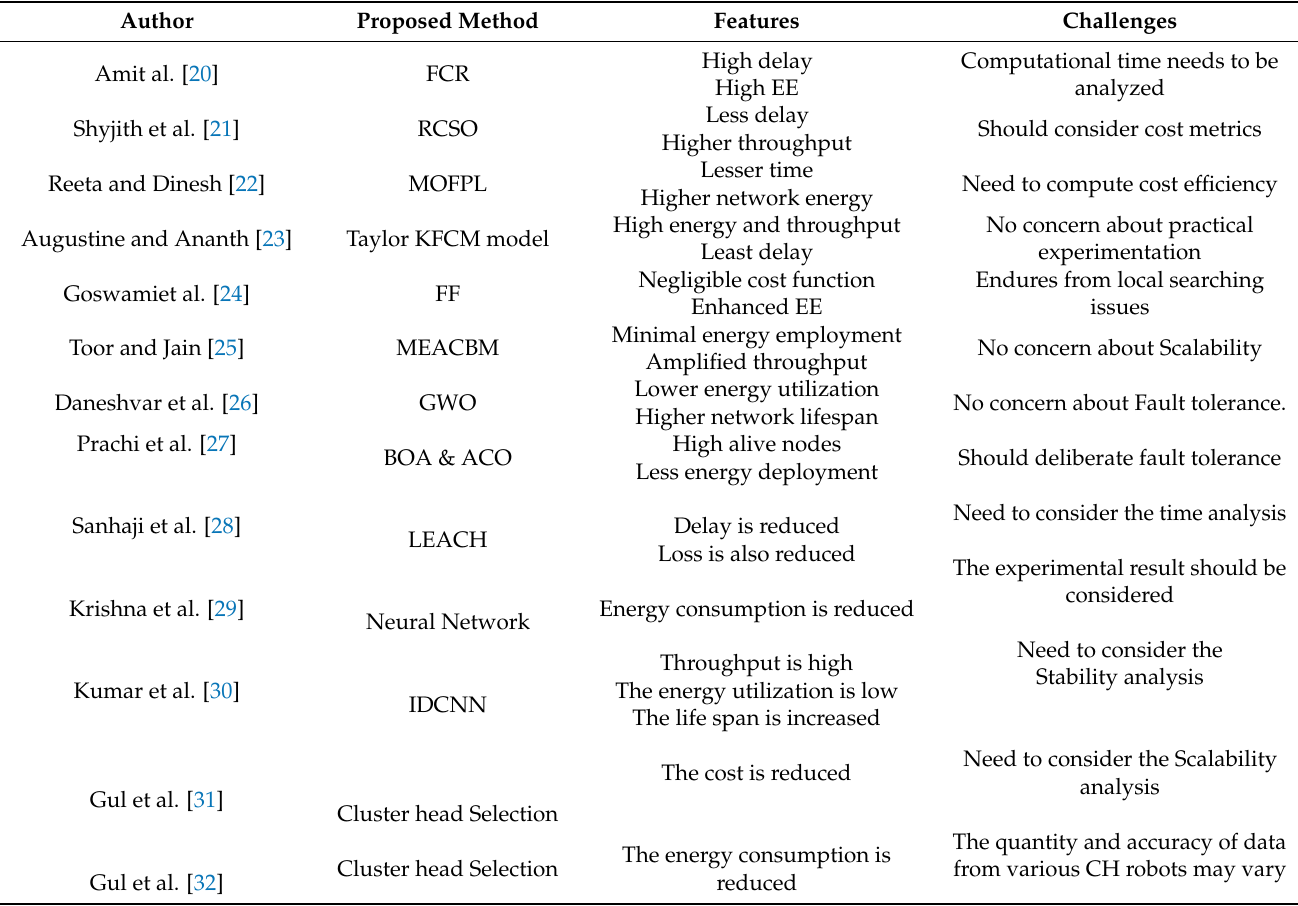
Table 1. Reviews on CHS models in WSN.